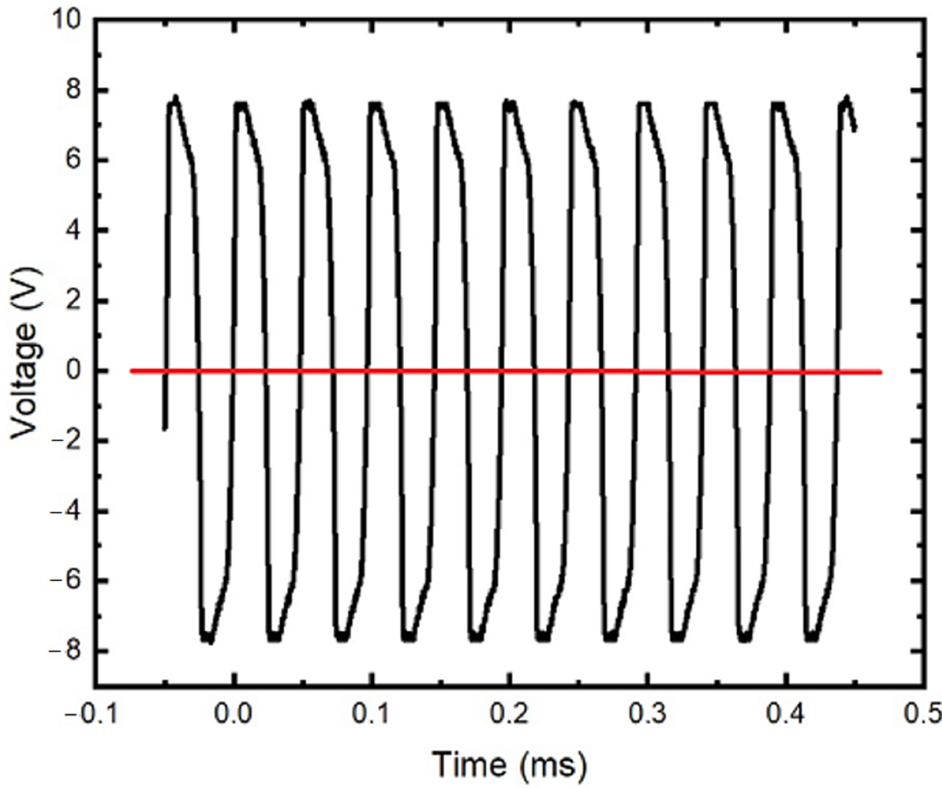
Figure 12. Oscillator self–oscillating mode (black line) and excitable modes (red